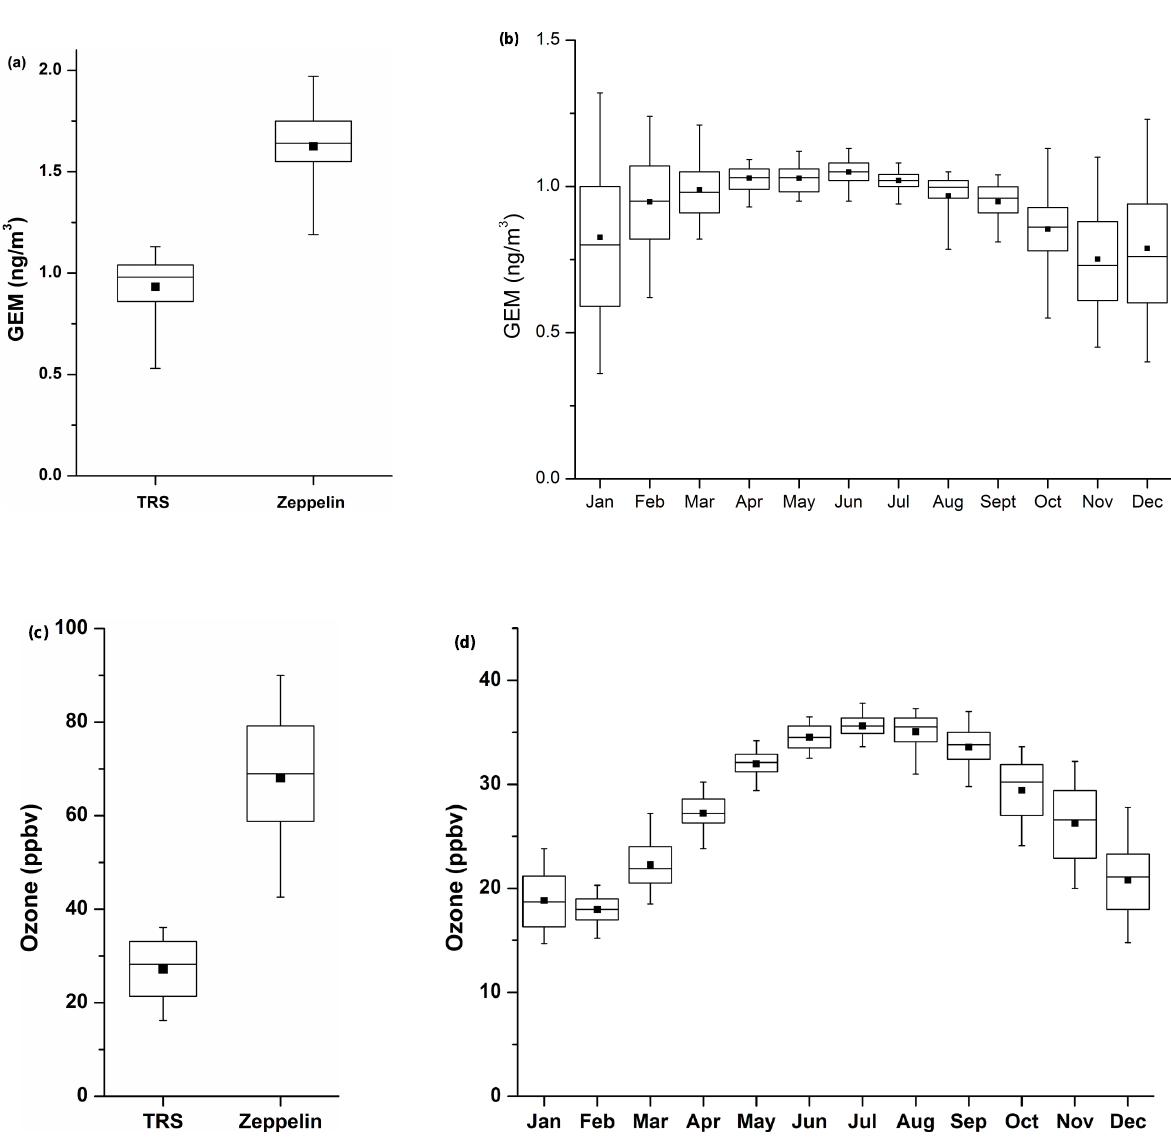
Fig. 2. (a) Box and whisker plot presenting the concentration distribution of GEM measurements at TRS (Antarctic) and Zeppelin (Arctic). (b) Box and whisker plot presenting the monthly GEM concentration distribution from all the data collected at TRS. The middle line in the box shows the median concentration, the box indicates the range between the 25th and the 75th percentile. Whiskers above and below the box indicate the 90th and 10th percentile respectively. The filled square shows the arithmetic mean. (c) and (d) is the same as (a) and (b) but for O 3